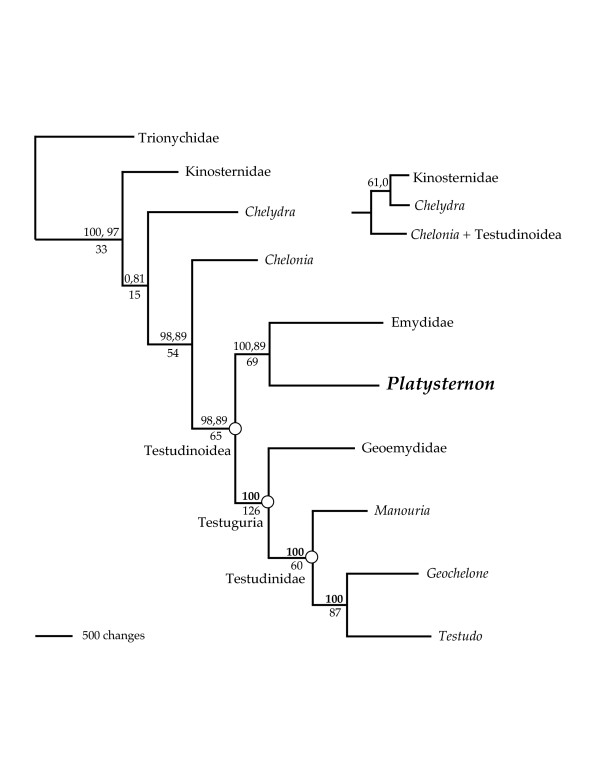
Phylogenetic relationships of cryptodires based on a combined analysis of large mt sequences and nuDNA. Parsimony phylogram. Inset: alternative topology recovered by the BI analysis. Numbers above branches refer to BI posterior probabilities and MP bootstraps respectively, while a single bold number above a node indicates the identical BI and MP support for that node. Numbers below the nodes refer to decay indices.